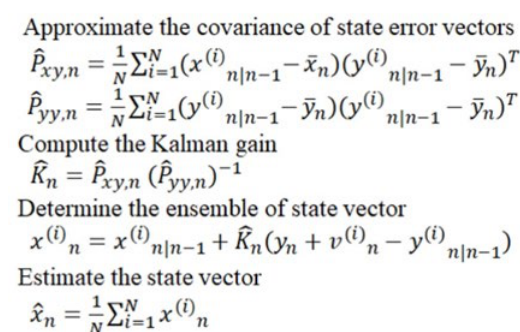
. The state estimation is 𝑥𝑥 𝑛𝑛